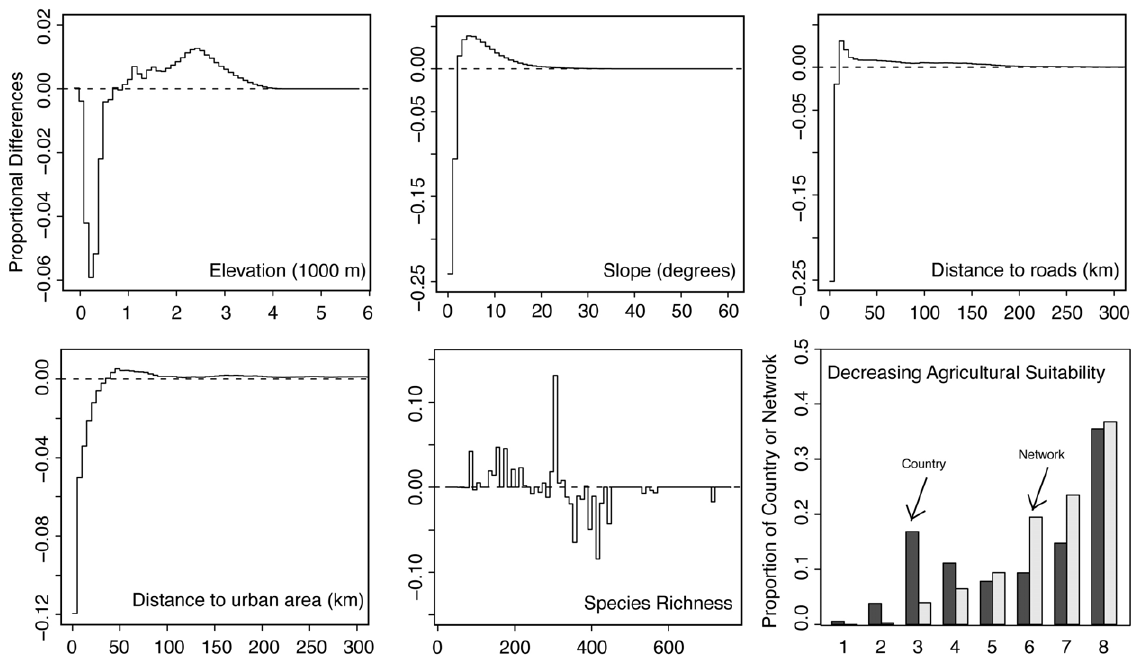
Figure 2. A full description of the IUCN I/VI protected area network for the United States. Variables include elevation, slope, distance to roads, distance to urban areas, species richness, and agricultural suitability. The x-axis corresponds to the variable being measured. The y-axis is the difference between the proportion of the country at each interval and the proportion of the network at the same interval. Values greater than zero (dashed horizontal line) indicate a disproportionate level of protection, while values less than zero indicate a disproportionate absence of protection. Visualizing network distributions in this way allows one to see discrepancies in protection across wide ranges of variables at a high resolution.